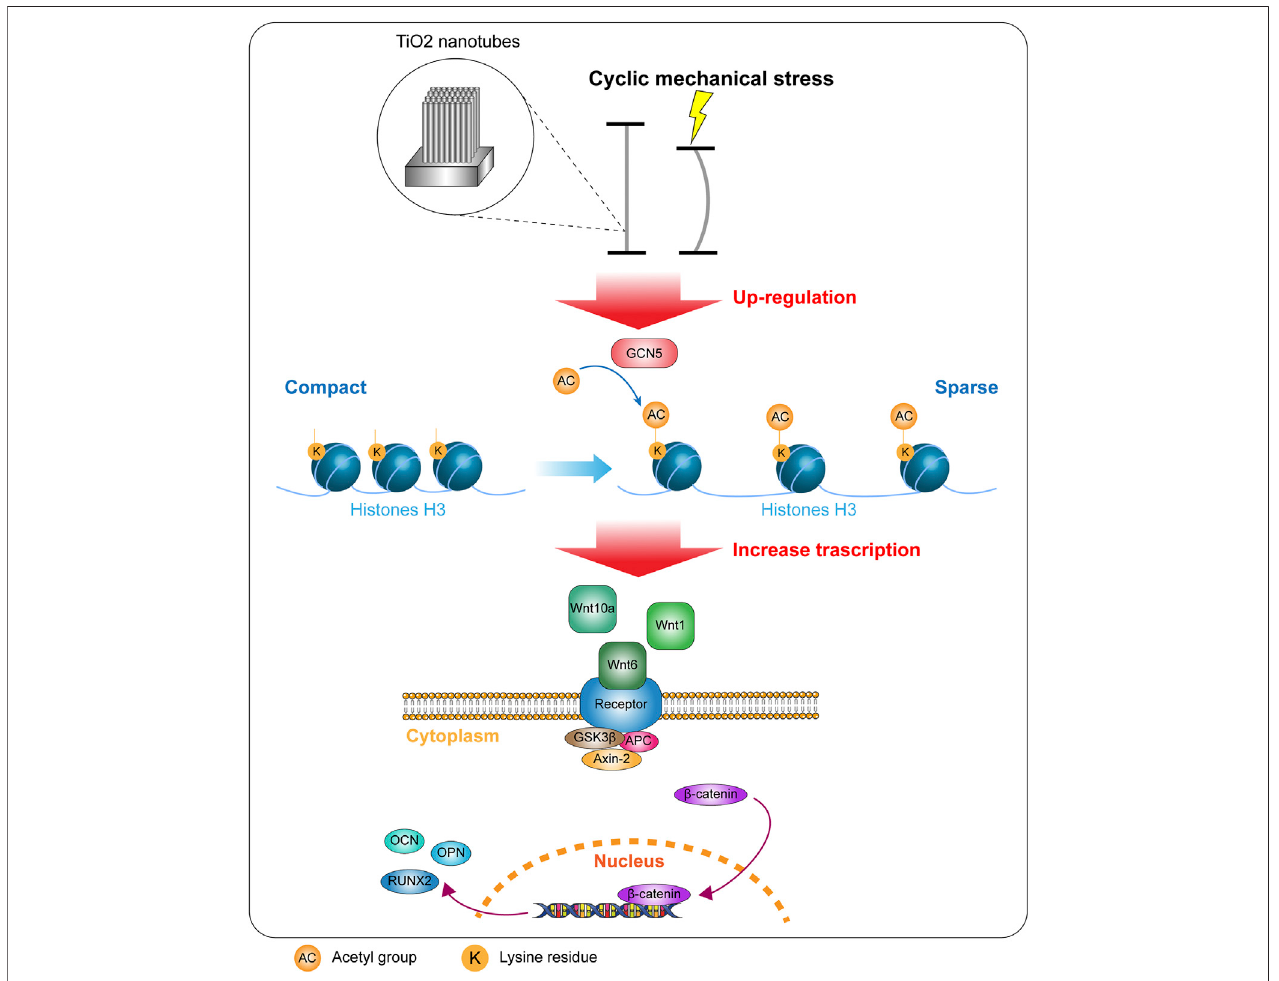
FIGURE9| CyclicmechanicalstrainupregulatedtheexpressionofGCN5andpromotedthelevelofacetylationofH3K9,therebyincreasedtranscriptionofrelated Wnt ligands and activating the Wnt signaling pathway.